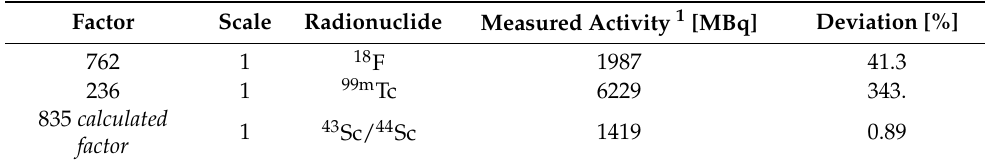
Table 4. Results obtained for the scandium-43/44 mixture